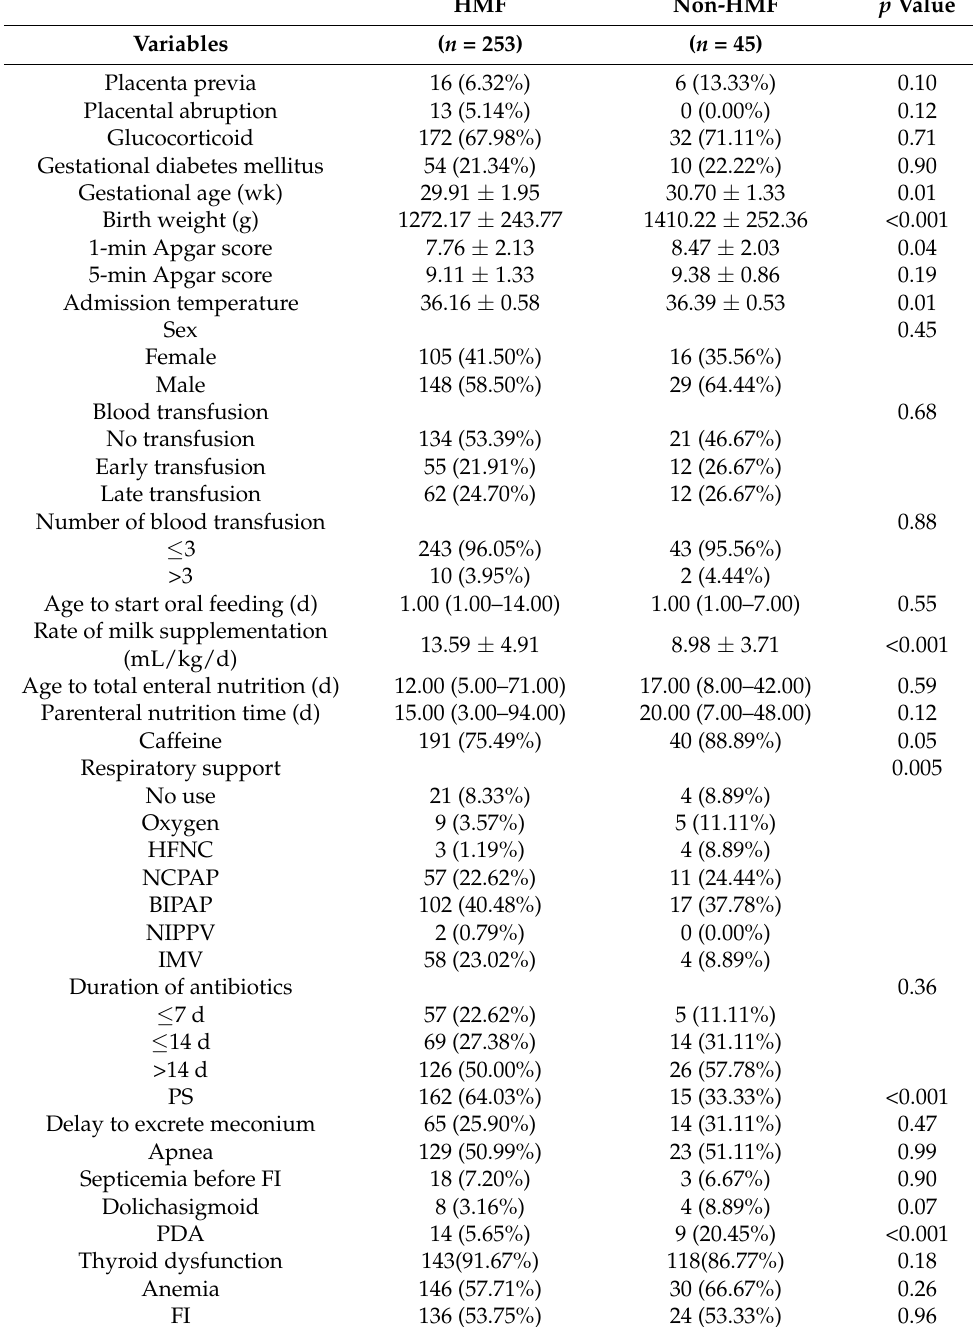
Table 2. Maternal pregnancy and clinical characteristic of infants, by HMF or non-HMF. Dates